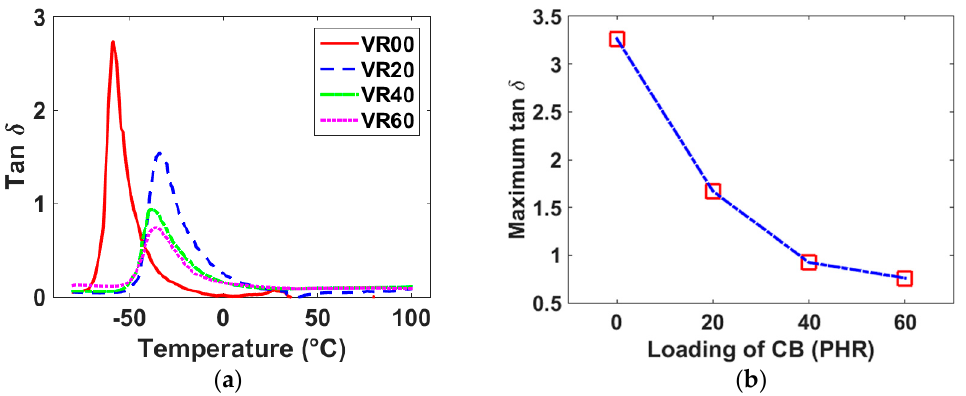
Figure 5. ( a ) Loss factor (tan δ ) vs. temperature curves for the four vulcanizates from − 80 °C to 100 °C. ( b ) Variation of maximum tan δ value with CB content.